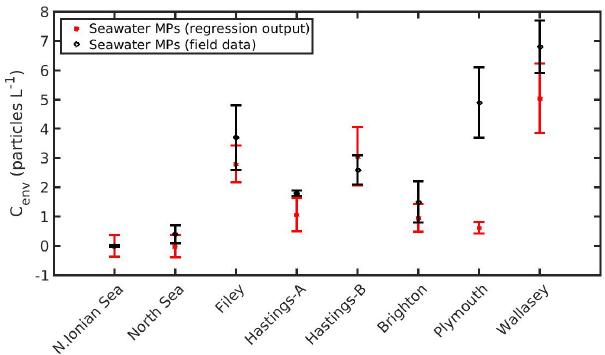
Figure 13. Prediction of seawater microplastics concentration by applying Eq. (20) in the northern Ionian Sea, North Sea (present study), and six areas around the UK (Filey, Hastings-A, Hastings- B, Brighton, Plymouth, and Wallasey; Li et al.,